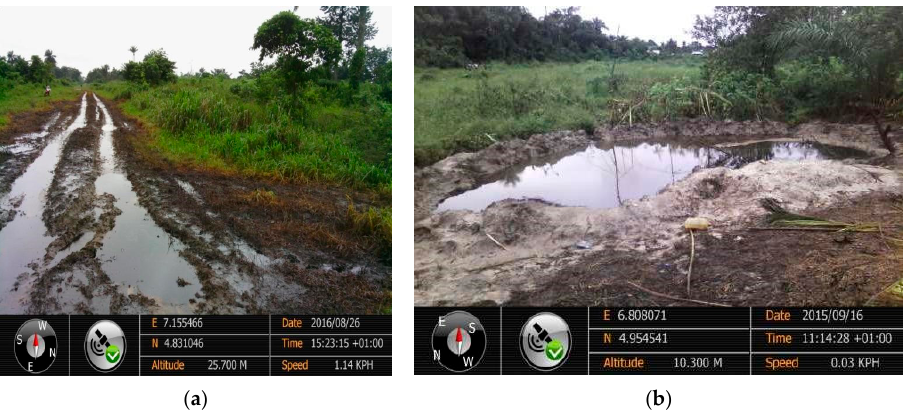
Figure 1. Land Crude Oil Spill Images. ( a ) Sample image from sample images; ( b ) Sample Images from Case Images.